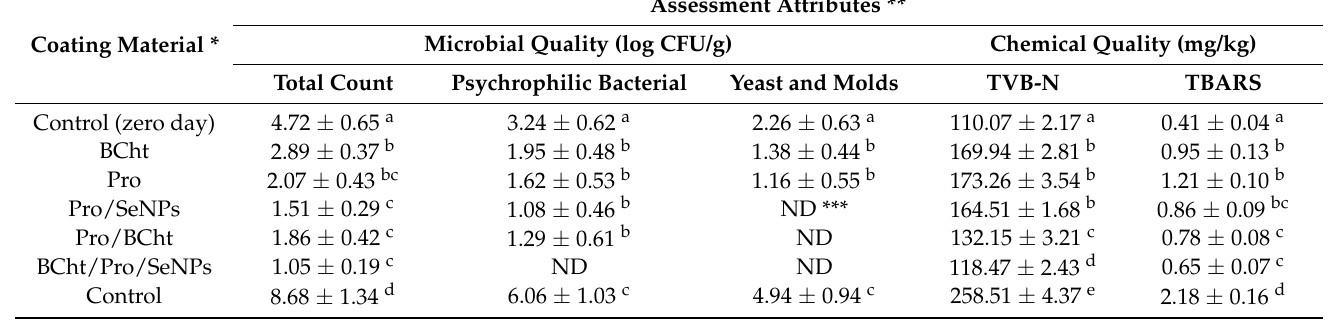
Table 3. Microbial and chemical attributes of coated fillets with antimicrobial compounds, after cold storage for 7 days at 4 ◦ C.